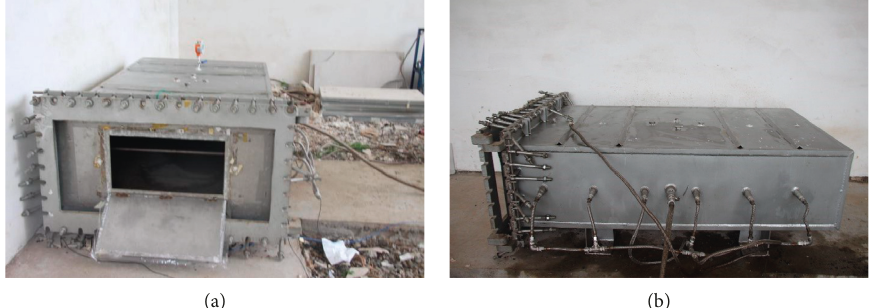
Figure 3: Rotary pressure relief member of the explosion container, ignition system, gas transmission system, and measurement